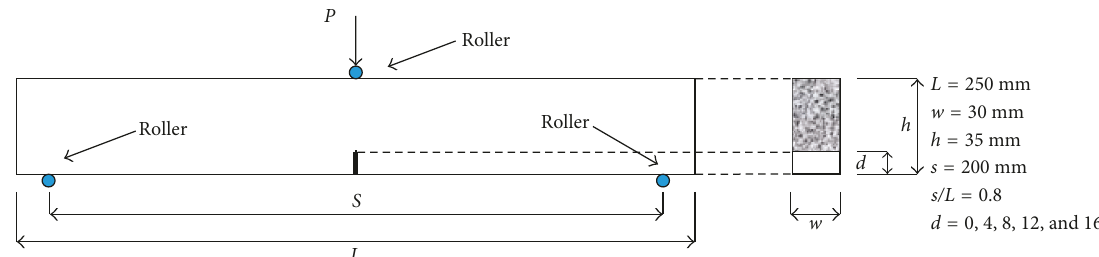
Figure 3: A schematic illustration of the three-point bending test on a single-edge notched beam.